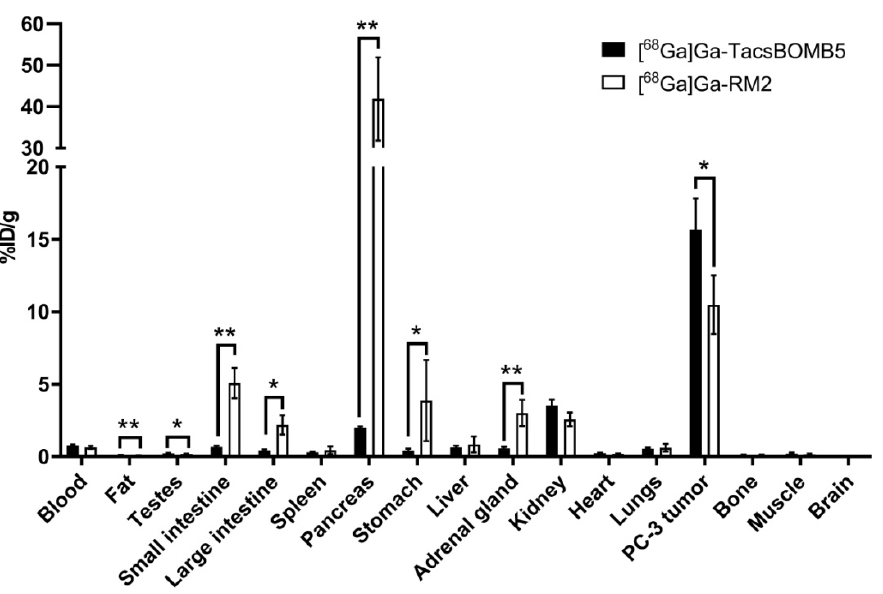
Figure 6. Comparison of 68 Ga-TacsBOMB5 and 68 Ga-RM2 uptake in PC-3 tumor xenografts and major organs/tissues in mice at 1 h post-injection. Error bars indicate standard deviation. * p < 0.05, ** p < 0.01.